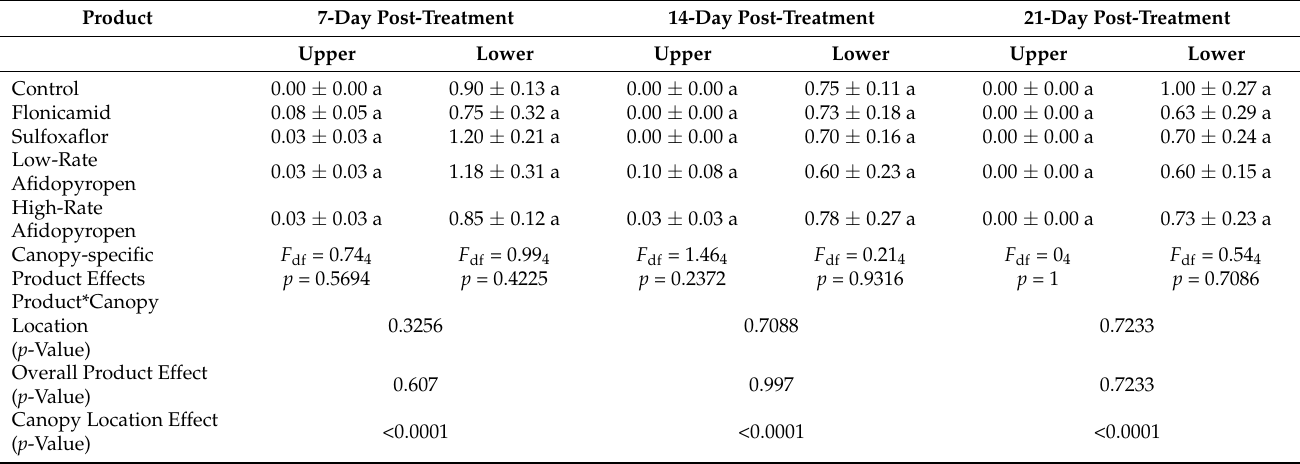
Table 5. Mean ± SEM of mummified aphids per leaf across treatments and sample days in 2020. Differing letters in columns indicate a significant difference between treatments ( p < 0.05 Tukey’s HSD). Canopy-specific product effects and p -values for product*canopy interaction, overall product effect, and canopy location across sampling days are also shown. Application rates for each aphicide are based on the standard label rate.